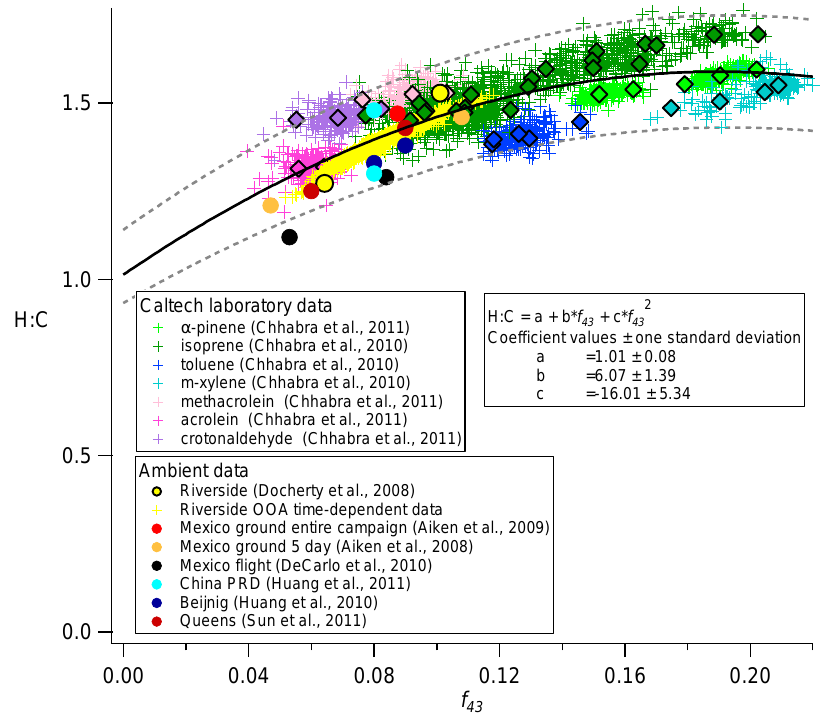
Fig. 2. Parameterization of H:C in terms of f 43 for SOA/OOA, using OOA components (total OOA, SV-OOA, LV-OOA) obtained from PMF analysis of HR-AMS ambient datasets and SOA formed in laboratory studies. It is noted that multiple experiments were performed for each SOA precursor in the laboratory studies. The solid diamonds are the binned laboratory data. The dotted gray lines are ± 10% from the fitted